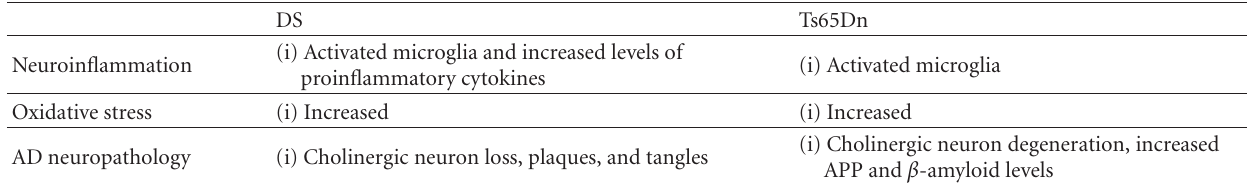
Table 5: Neurodegenerative processes in DS and in the Ts65Dn